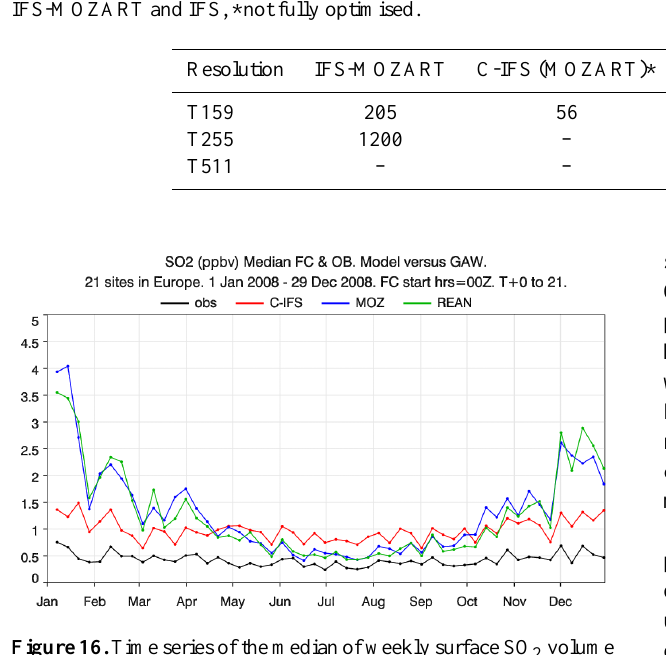
Figure 16. Time series of the median of weekly surface SO 2 volume mixing ratios (ppb) in Europe (21 GAW sites) and model results of C-IFS, MOZ and